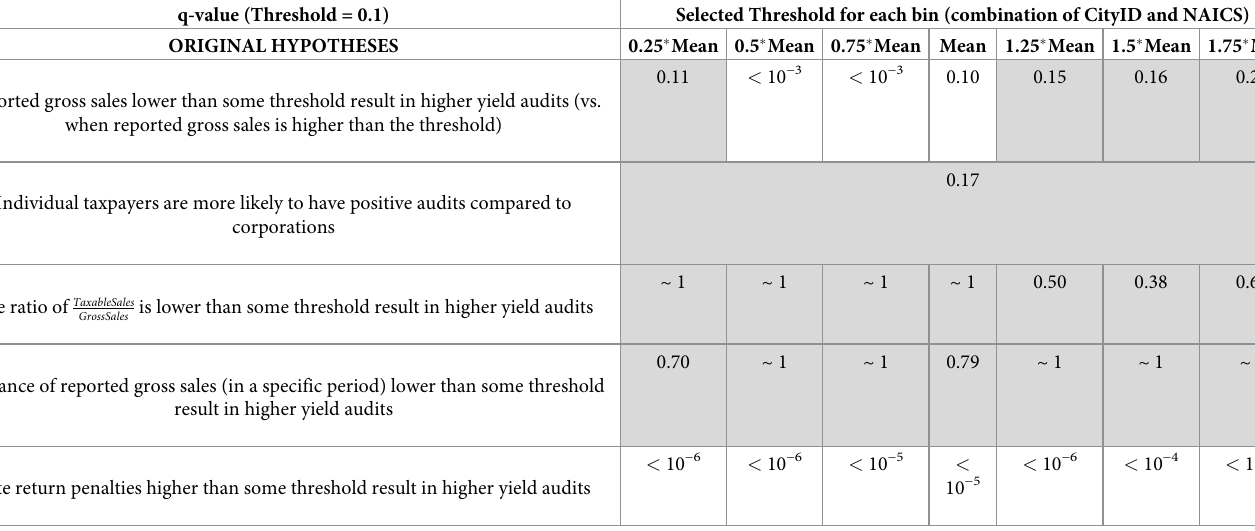
Table 1 : Wilcoxon-ranksum test applied to the hypotheses. A result less than 0.1 signifies a statistically significant result. Grayed-out cells mark non-significant results. “~ 1” results denote probabilities arbitrarily close to 1.